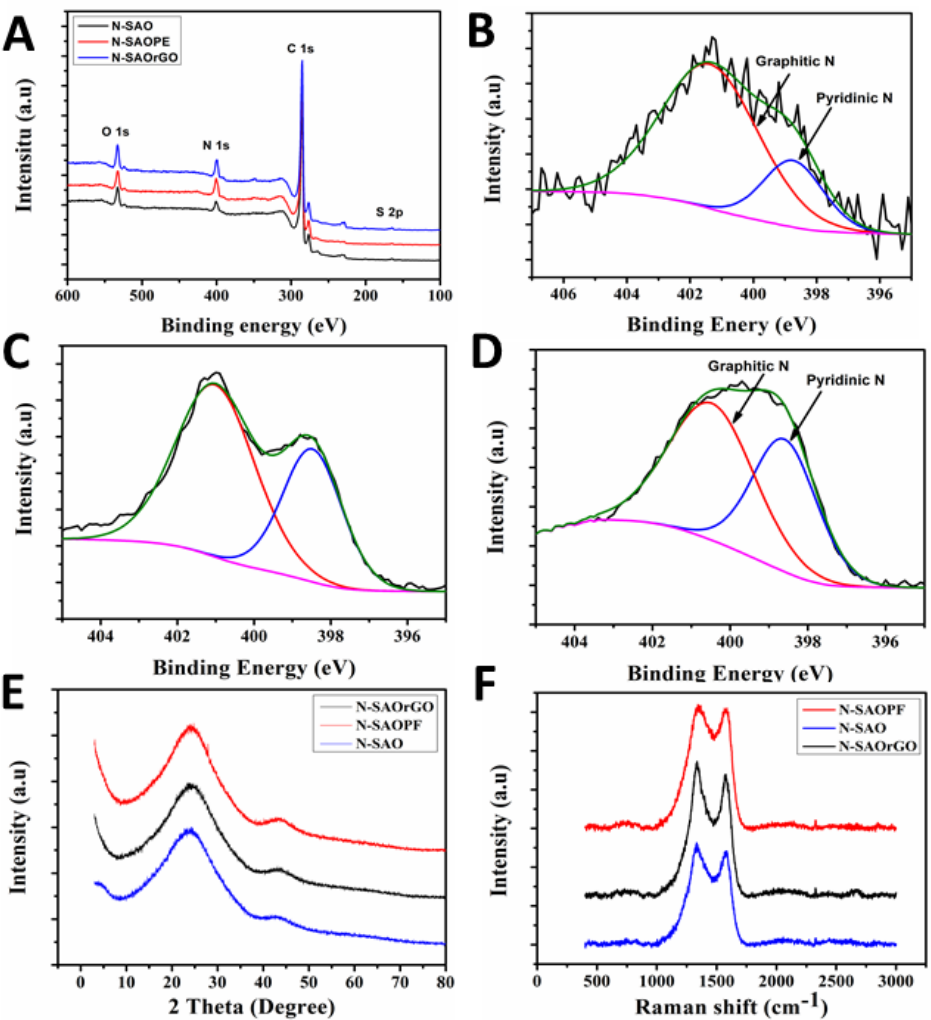
Figure 3. Survey spectrum of ( A ) N-SAO, N-SAOrGO and N-SAOPF and high resolution N1s XPS spectrum of ( B ) N-SAO, ( C ) N-SAOrGO, and ( D ) N-SAOPF. ( E ) XRD pattern and ( F ) Raman peaks of N-SAO, N-SAOrGO and N-SAOPF. Table 2. Percentage atomic concentration of nitrogen species present in N-SAO, N-SAOGO and N- SAOPF.